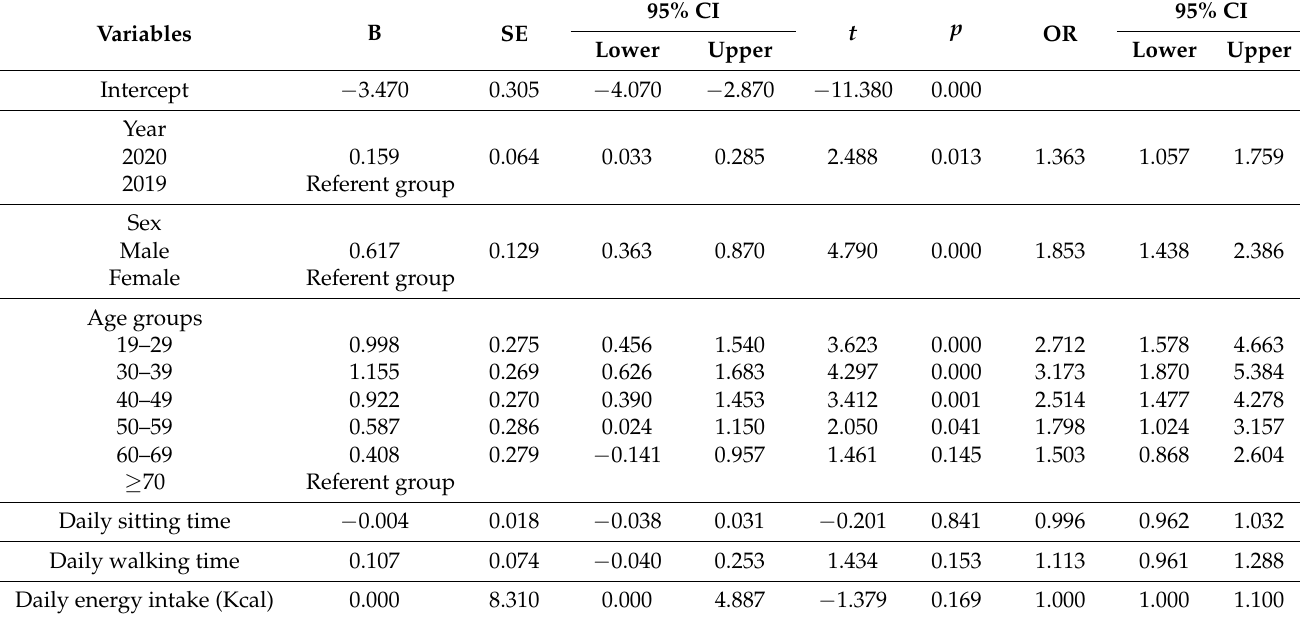
Table 4. Logistic regression analysis on severe obesity in Korean adults aged 19 and